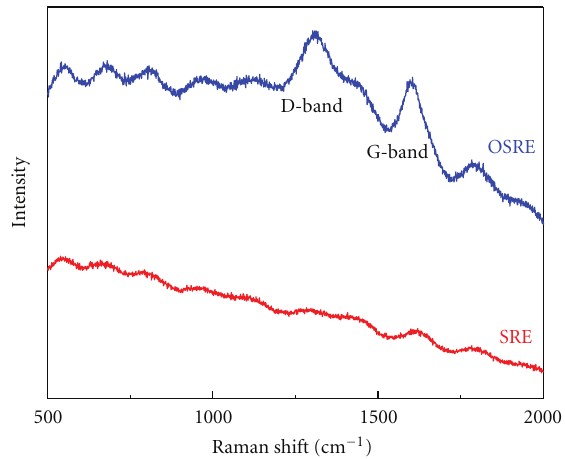
Figure 5: Raman spectra of used catalyst after SRE and OSRE reaction.